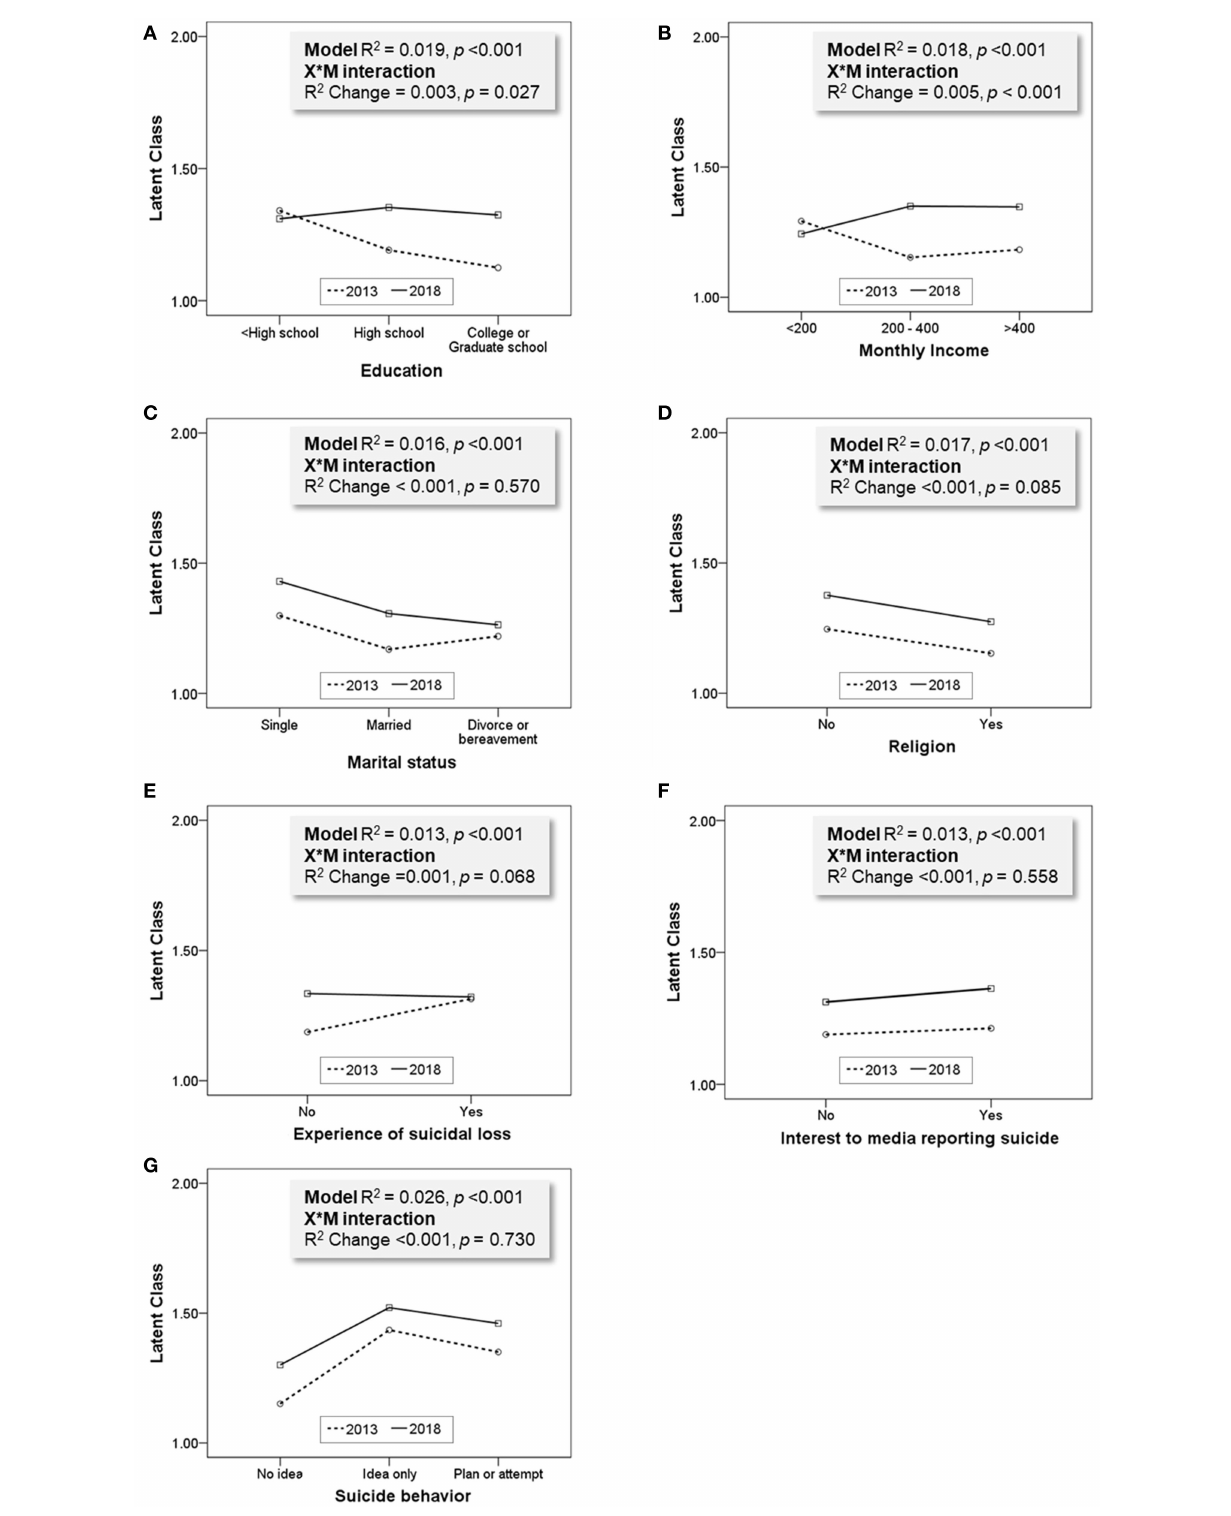
FIGURE4 Moderating effect of each model. Age and sex were adjusted as covariates in each model. (A) Education (0 = < High school, 1 = High school, 2 = College or graduate school), (B) Monthly income (10 4 KRW, 0 = < 200, 1 = 200–400, 2 = > 400), (C) Marriage (0 = Single, 1 = Married, 2 = Divorce or bereavement), (D) Religion (0 = No, 1 = Yes), (E) Experience of suicidal loss (0 = No, 1 = Yes), (F) Interest in media reporting suicide (0 = No, 1 = Yes), (G) Suicide (0 = No idea, 1 = Idea only, 2 = Plan or